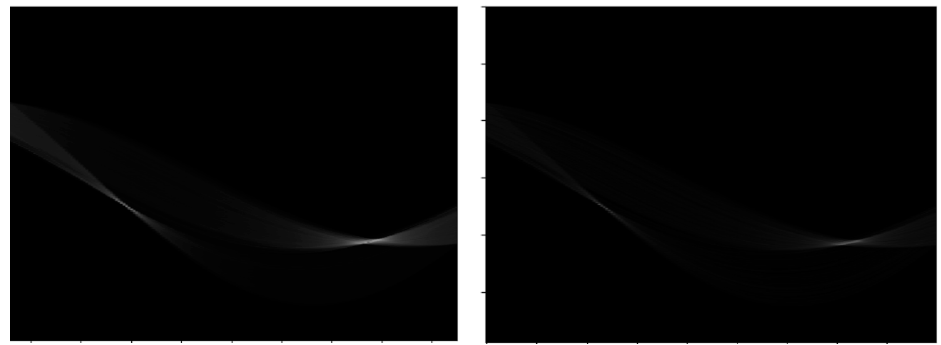
Figure 17. Original Hough transform accumulation buffers ( left ) versus probabilistic Hough trans- form ones ( right ).